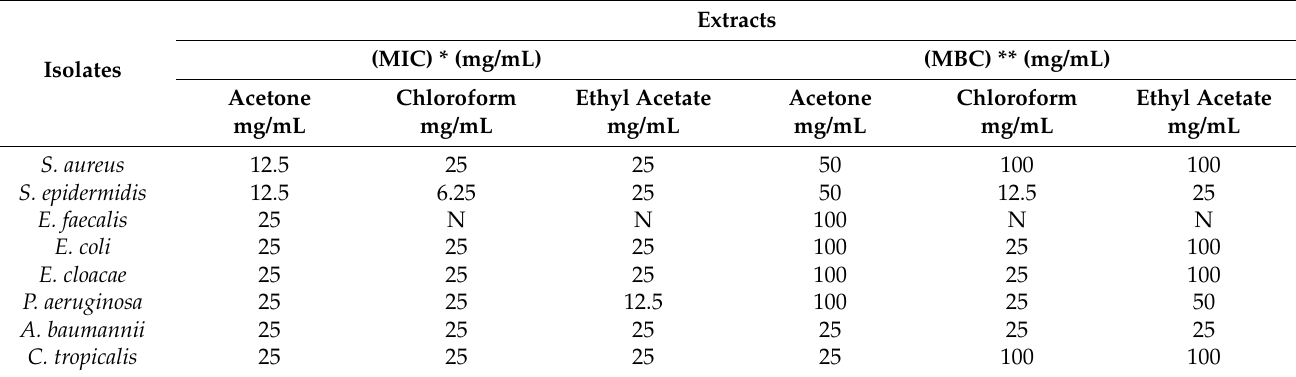
Table 4. Minimum inhibitory concentration (MIC) and minimum bactericidal concentration (MBC) for different extracts of Solenostemma argel against respiratory tract infections